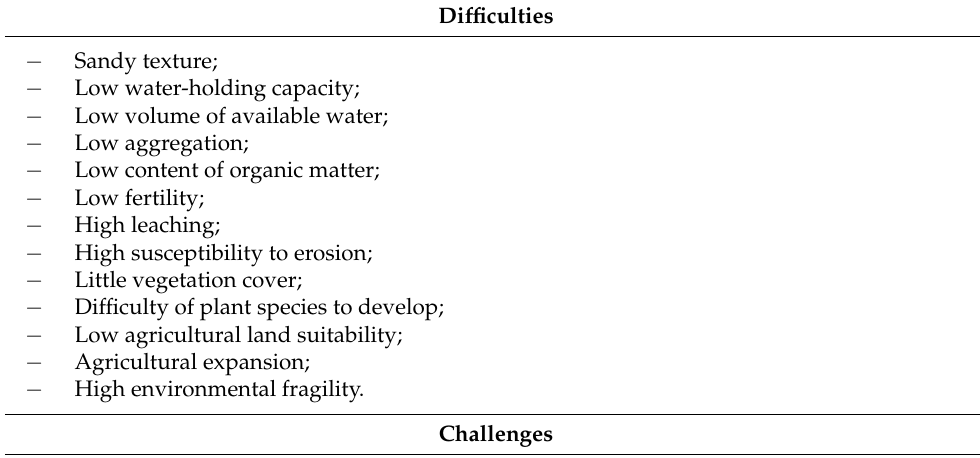
Table 12. Difficulties and challenges associated with the Quartzipsamments of the Southwest of Rio Grande do Sul State, southern Brazil.